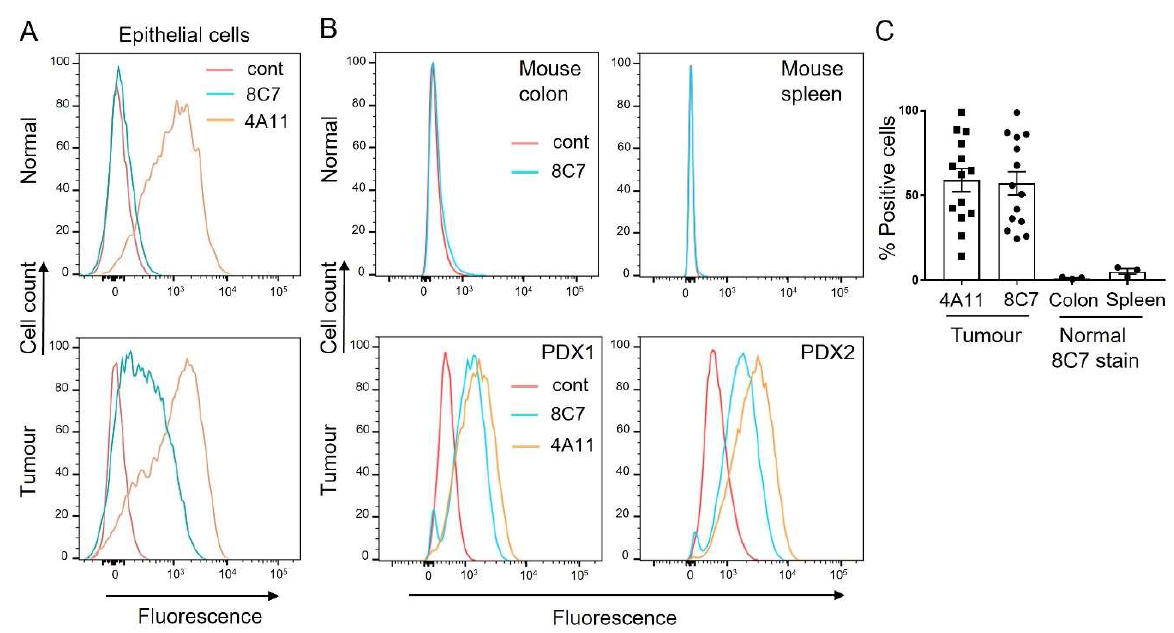
Figure 2. Anti-ADAM10 mAb 8C7 preferentially binds human colon tumour cells compared to normal cells. ( A ) Single cell isolates from colon tumour and matched normal patient tissue were stained with the anti-ADAM10 antibodies 8C7 and 4A11, and with antibodies against CD45 and EpCam, and analysed by flow cytometry. Histograms show normalised staining of epithelial cell populations (EpCam positive, CD45 negative). ( B ) Tumours were recovered from mice bearing two human colorectal PDX lines, and single cell isolates were stained with 8C7, 4A11 or control IgG, before analysis by flow cytometry. Normal colon and spleen were also analysed for 8C7 binding (human-specific 4A11 was not used). Histograms show overlaid binding of ADAM10 antibodies with an isotype control. ( C ) Quantitation of 8C7 binding to tumour cell isolates, from multiple passages of six distinct colorectal PDX tumour lines ( n = 14 tumours), compared to normal tissue (% positive cells). Binding of the anti-human ADAM10 mAb 4A11 to PDX tumour cells is also shown for com- parison.